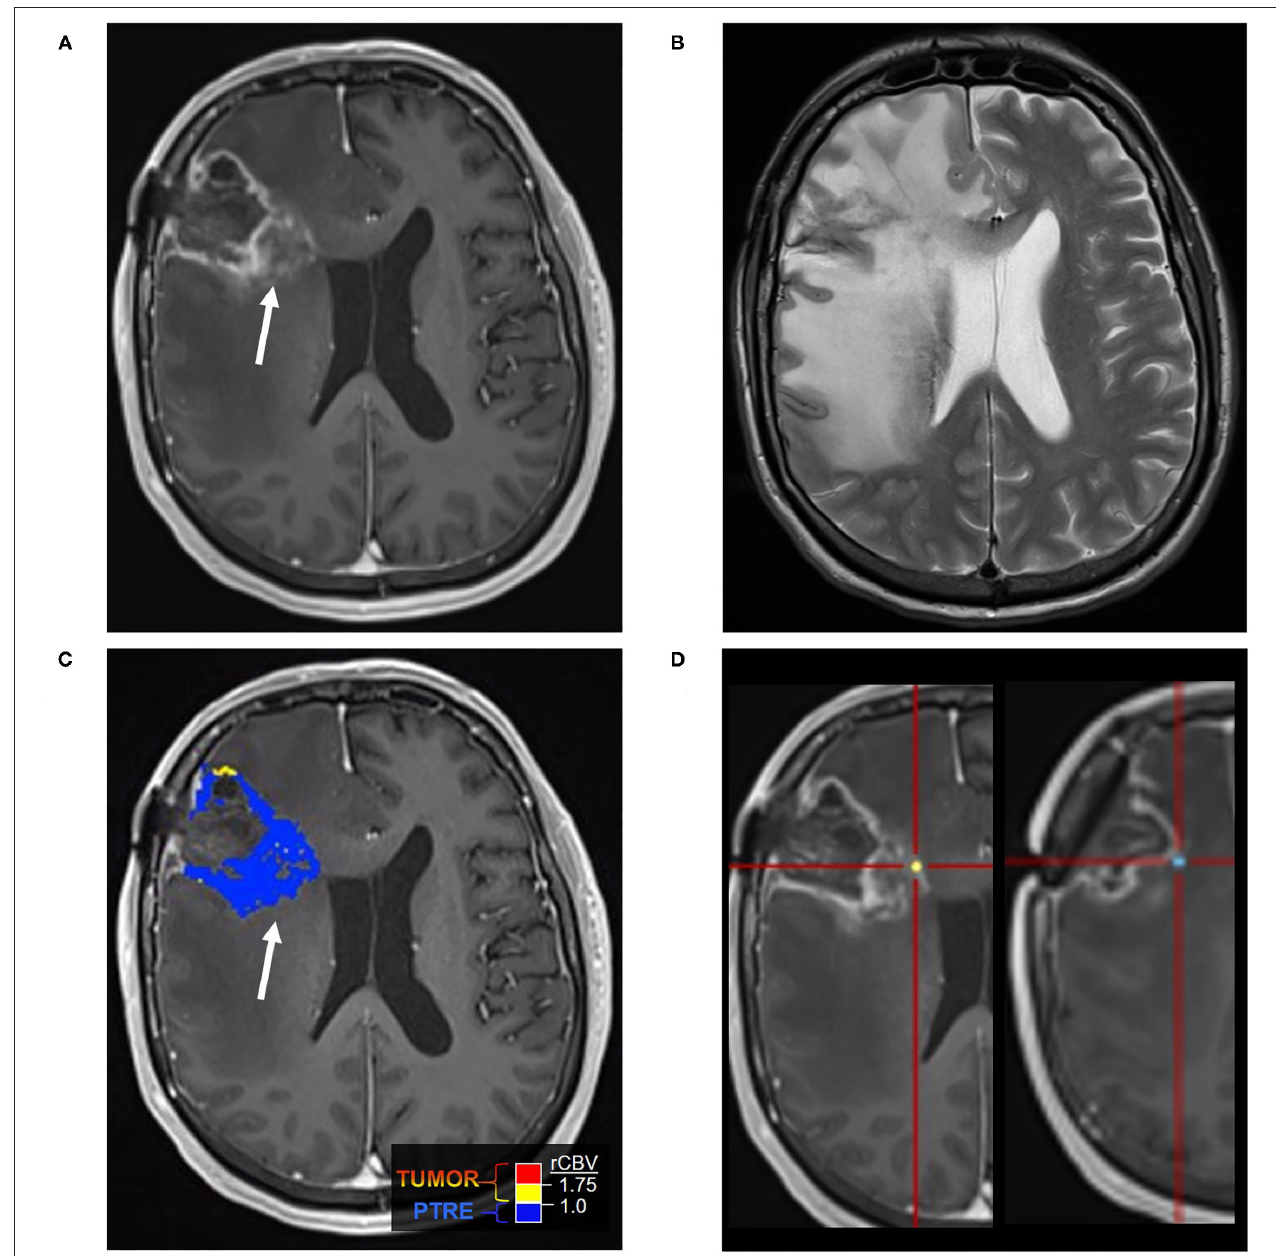
FIGURE 1 | Posttreatment changes on Dynamic Susceptibility (DSC) MRI: A 58-year-old man with right frontal glioblastoma (GBM) status post resection and adjuvant radiation with concomitant temozolomide presented 6 months after resection with left facial droop and left-sided weakness. Initial CT and Contrast-enhanced MRI (CE-MRI) showed an increased mass effect and ill-defined enhancement around the resection cavity, indeterminant for recurrent tumor vs. posttreatment effects. (A) Axial postcontrast T1-weighted image demonstrates a linear enhancement around the right frontal resection cavity with more ill-defined nodular enhancement along the posteromedial margin (arrow). (B) Axial T2-weighted image shows T2 hyperintense signal and mass effect throughout the right frontal and parietal lobes. (C) DSC Fractional tumor burden (FTB) map derived from rCBV thresholds shows low FTB around the resection cavity favoring posttreatment changes (D) Stereotactic biopsies were performed and cross-registered retrospectively to areas of enhancement. Pathology demonstrated virtually entirely necrotic tissue with no viable tumor, concordant with the rCBV map.